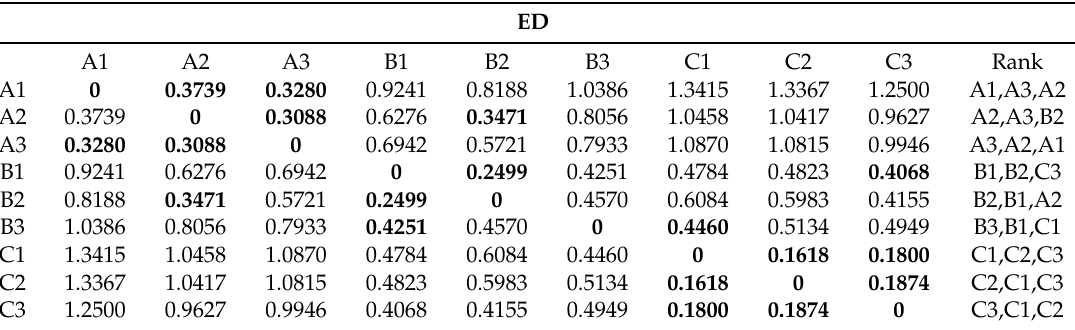
Table 2. The performance of ED for the AVIRIS dataset.